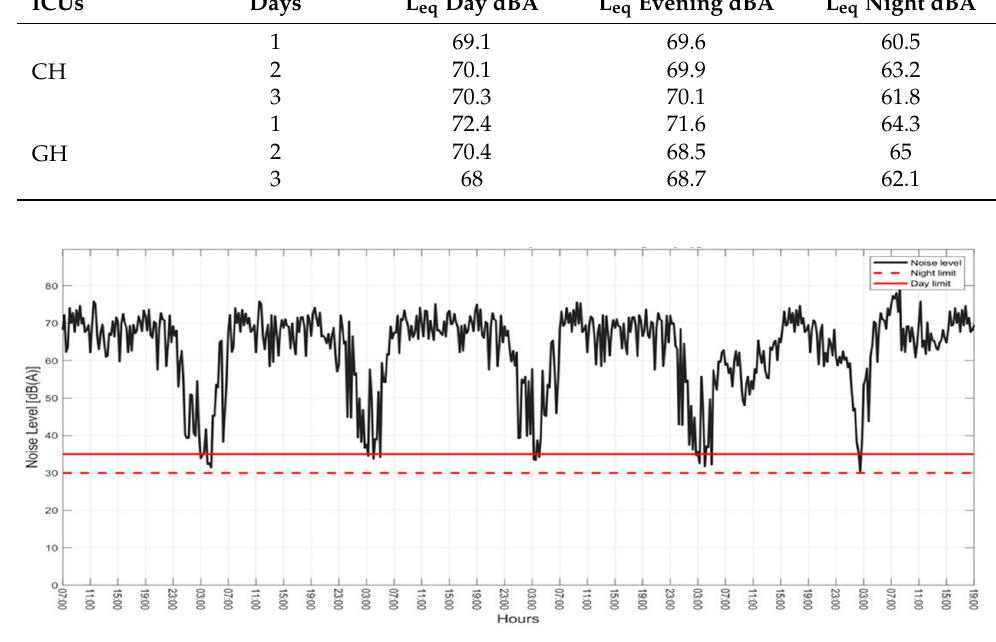
Figure 6. Shows the weekly noise level in the CH. Note: The middle line represents 35 dBA, the WHO-recommended noise level during the day, while the lowest line (dash line) represents 30 dBA, the WHO recommendation during the night. The noise produced by this equipment greatly surpasses the acceptable noise levels in the ICU.